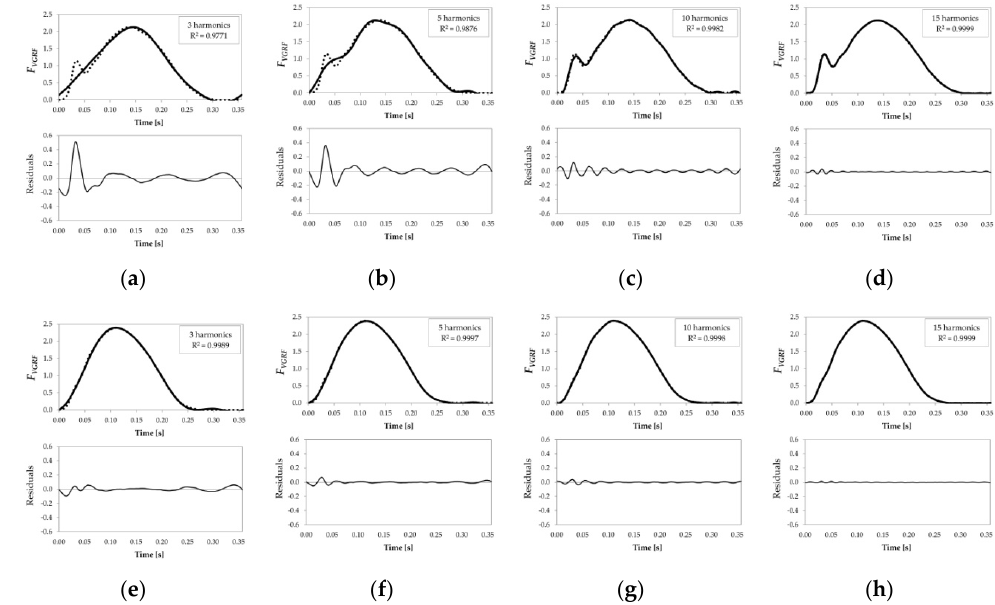
Figure 9. Impact of the number of harmonics on the accuracy of the F VGRF curve modeling: ( a – d ) heel-strike running; ( e – h ) forefoot-strike running: ( a , e ) model containing 3 harmonics; ( b , f ) model containing 5 harmonics; ( c , g ) model containing 10 harmonics; ( d , h ) model containing 15 harmonics (upper chart—the F VGRF curves, lower chart—residual plots; dot line—result of laboratory test, solid line—result of the F VGRF fitting).